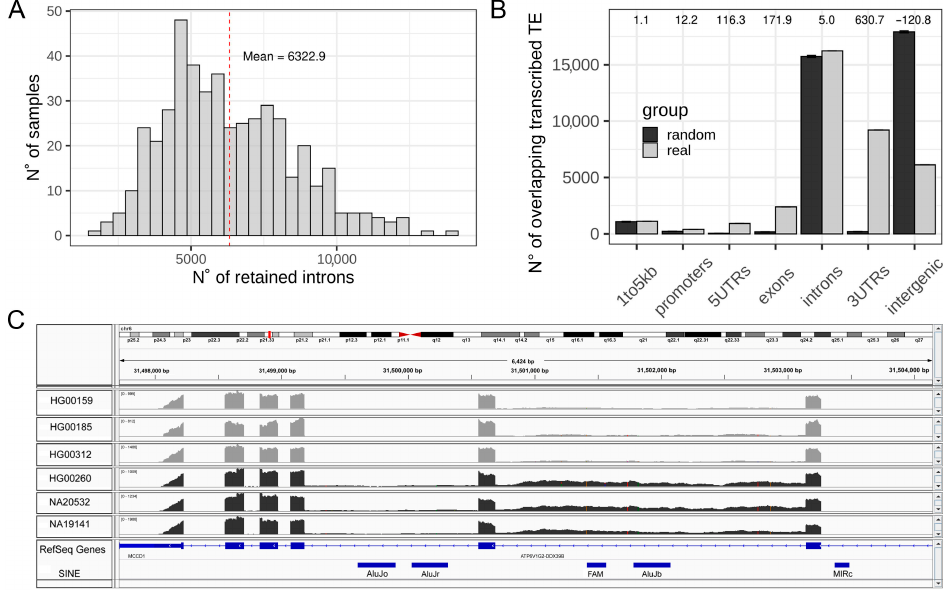
Figure 1. Exploration of IR and TEs in RNA-seq data from Geuvadis. ( A ) Distribution of the number of retained introns per samples in the Geuvadis dataset. ( B ) Genomic distribution of transcribed